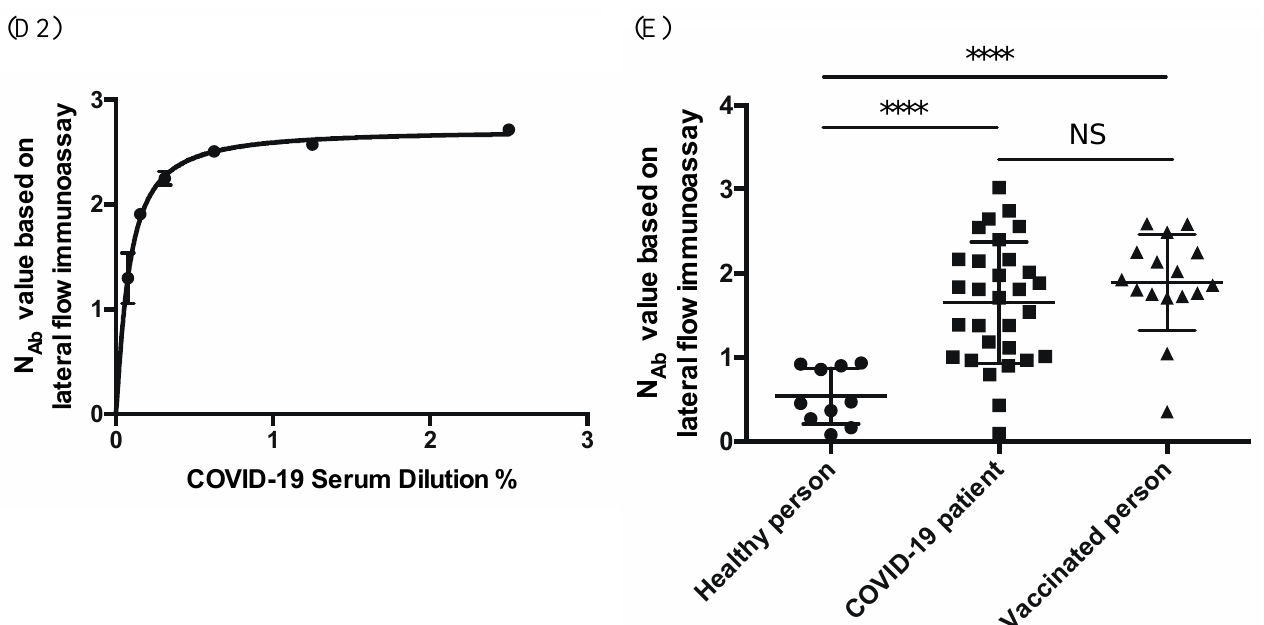
Figure 2. ( A ) SARS-CoV-2 Neutralizing Antibody Rapid Test Cassette (coupled with a spectrum- based reader) loaded with different COVID-19-confirmed cases. Control line region shown as an orange dotted line; test line region shown as a yellow dotted line. ( B ) SARS-CoV-2 Neutralizing Antibody Rapid Test Cassette (coupled with a spectrum-based reader) loaded with samples from different vaccinated individuals. Control line region shown as an orange dotted line; test line region shown as a yellow dotted line. ( C ) The reflectance spectra of a mild case, with the reflectance spectra of the control line region shown as a black solid line; the reflectance spectra of the test line region shown as a red solid line. The x -axis is the unit of wavelength (nm). The y -axis is the arbitrary unit (AU). ( D1 ) Testing the N Ab value based on the lateral flow immunoassay with a dilution series of a severe case patient’s serum. Curve fit by the Hill equation (R-squared = 0.9582), and ( D2 ) is part of ( D1 ) (R-squared = 0.9649). ( E ) Comparison of the N Ab value based on the lateral flow immunoassay from healthy people ( n = 10), COVID-19 patients ( n = 30), and vaccinated people ( n = 16). **** p < 0.0001; NS indicates no significant difference ( p >